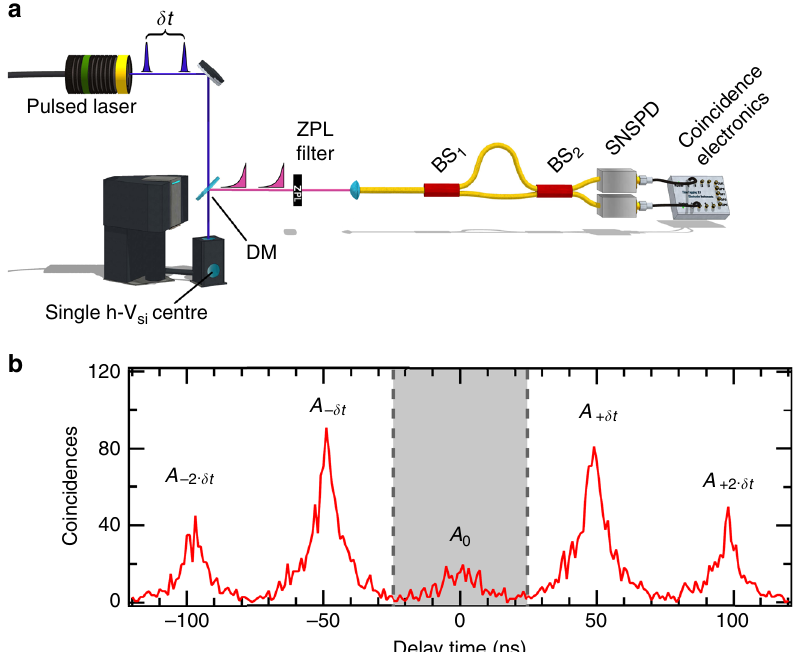
Fig. 2 Hong – Ou – Mandel interference for photon indistinguishability study. a Schematic set-up for HOM interference with two photons from a single h- V Si centre in SiC. Two laser pulses excite the h-V Si centre with a time delay δ t = 48.7 ns. Consecutively emitted ZPL photons are sent to an unbalanced Mach – Zehnder interferometer. SNSPD and coincidence electronics are used to record the two-photon statistics at the output. b Two-photon coincidence counts as a function of the detection time delay between both SNSPDs. The strongly suppressed peak at zero time delay witnesses Hong – Ou – Mandel interference. The grey area between dashed lines symbolises the integration time window that is used for evaluating the interference contrast V 0 = 0.69 ± 0.02. A two-photon coincidence occurs approximately every 84 s. The results shown are raw data without any